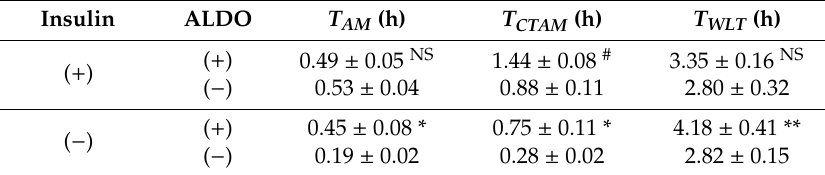
Table 4. The residency time of ENaC in the apical membrane how long an individual ENaC stays in the apical membrane each time after the insertion of ENaC into the apical membrane ( T AM = 1/ k E ) and the cumulative time how long an individual ENaC stays in the apical membrane during its whole life-time period before degradation ( T CTAM = ( 1 + K R / k D ) / k E ) , and whole life-time after the first insertion to the apical membrane ( T WLT = 1/ k E + N R ( 1/ k R + 1/ k I + 1/ k E ) + 1/ k D ) in the presence and absence of 100 nM insulin with and without 1 µ M aldosterone treatment for 20